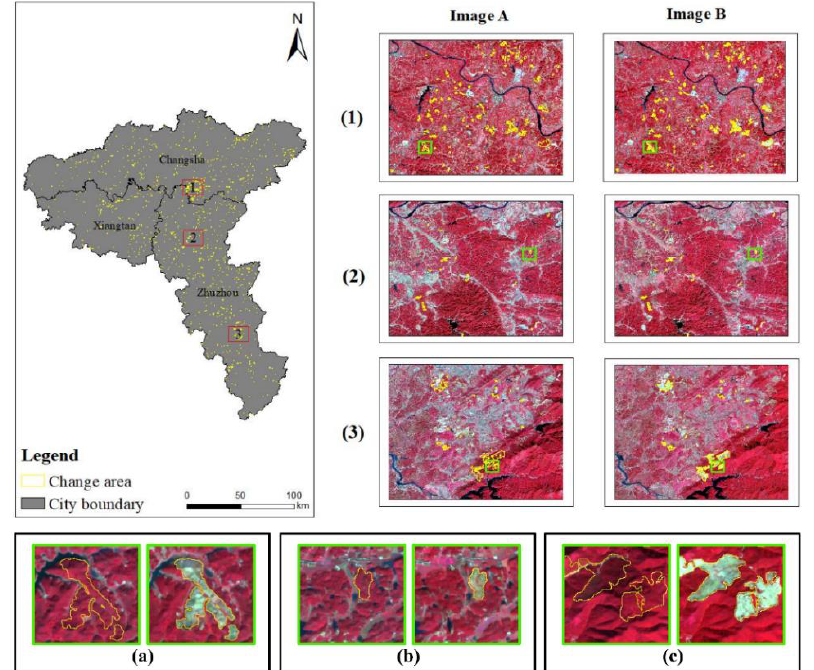
Figure 2. Example of change labels. The yellow area represents change areas. Images A and B are bitemporal images (acquired in autumn 2020 and 2021). (1), (2), and (3) are examples of partially enlarged annotations. ( a ), ( b ), and ( c ) is are the zoomed change areas in (1), (2) and (3). The image patches can be used in the proposed DSNUNet for forward calculation.